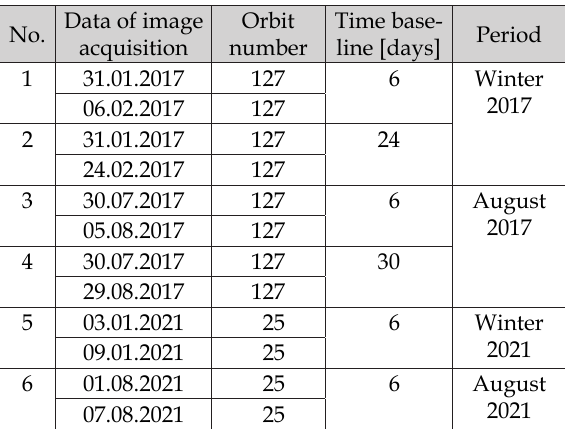
Table 1. Description of data used in the study.